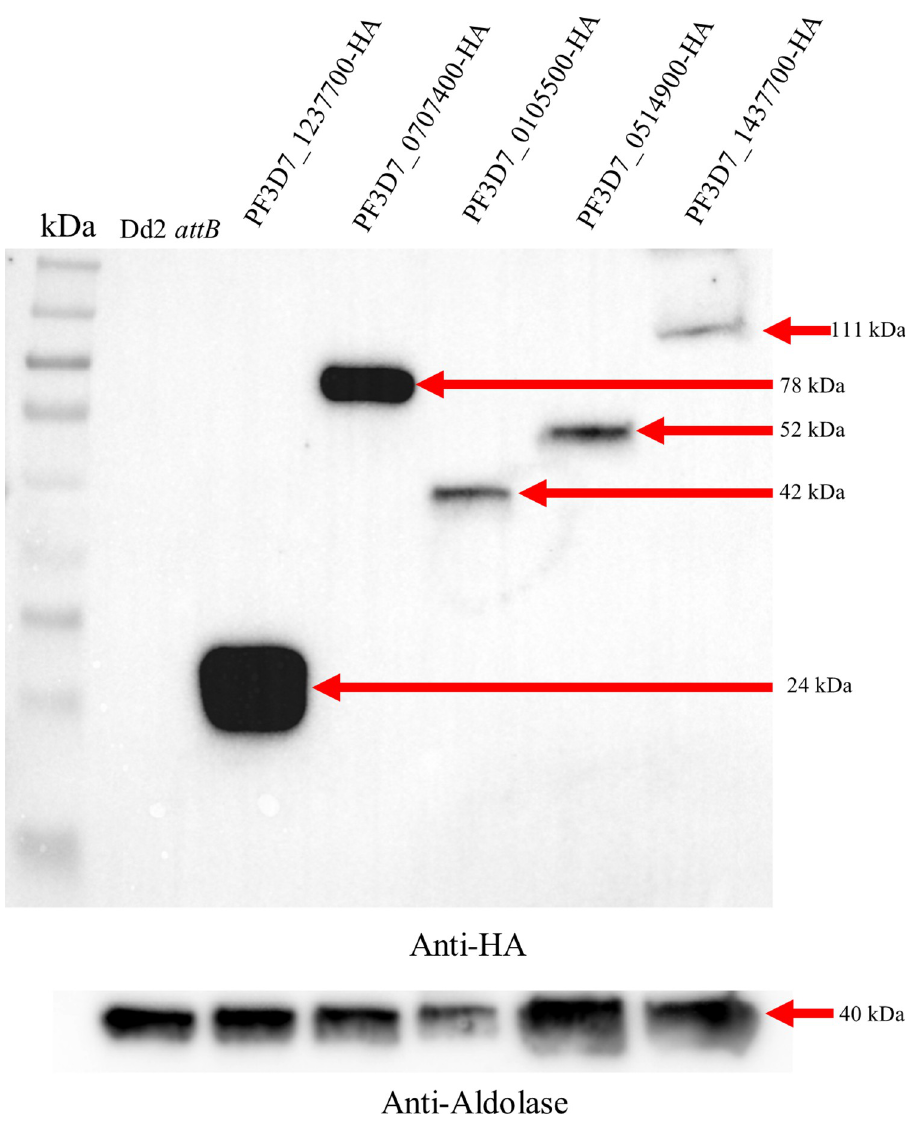
Fig 5. Western blot analysis of parasite lines generated for localization study. The PVDF membrane was probed with anti-HA antibody, stripped, and then probed with an anti-aldolase antibody as a loading control. Expected